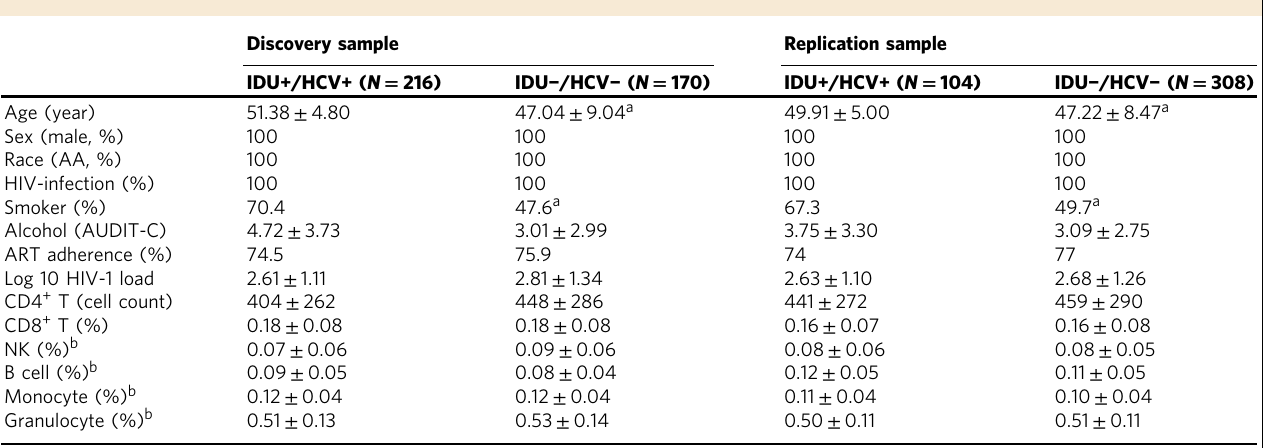
Table 1 Demographic and clinical